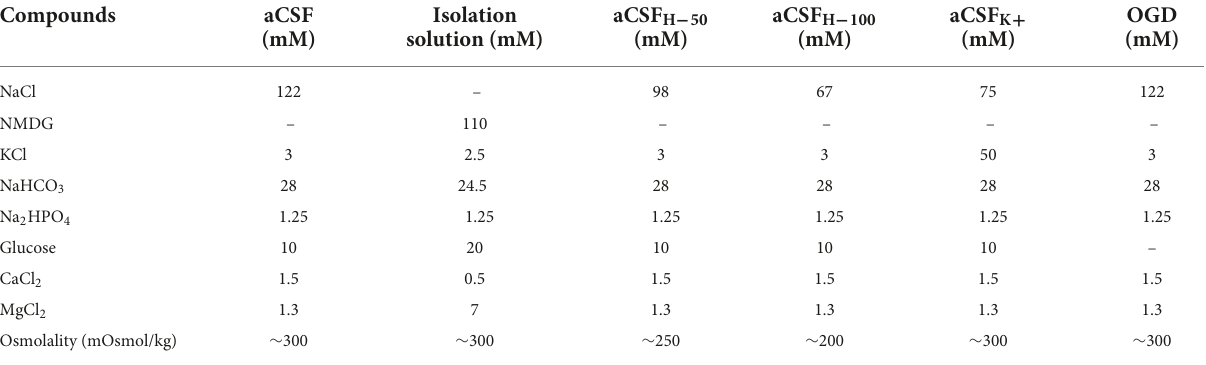
TABLE 1 Contents of experimental